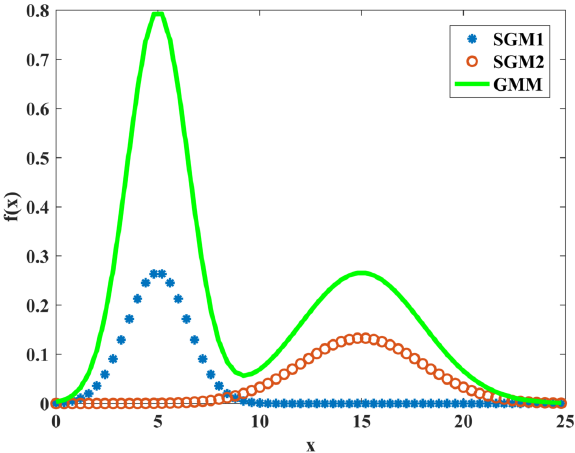
Figure 4. Two-component one-dimensional mixed Gaussian curve.